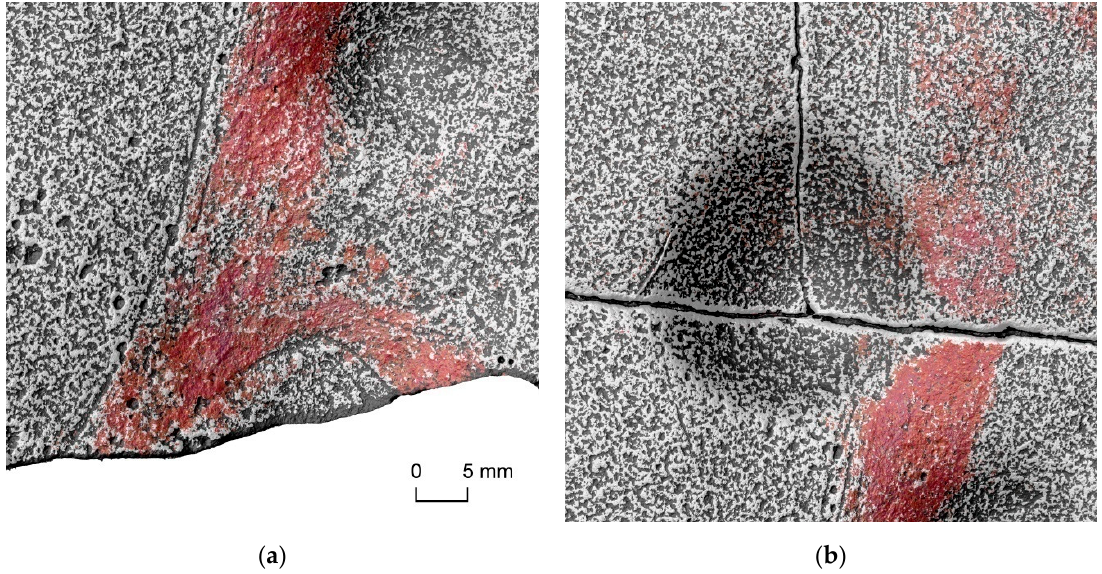
Figure 10. Overlay of hillshade layer with 50% transparency on pigment layer, which in turn, is superimposed on the high pass layer: ( a ) leg detail; ( b ) area that coincides with the fracturing of the piece into three fragments.